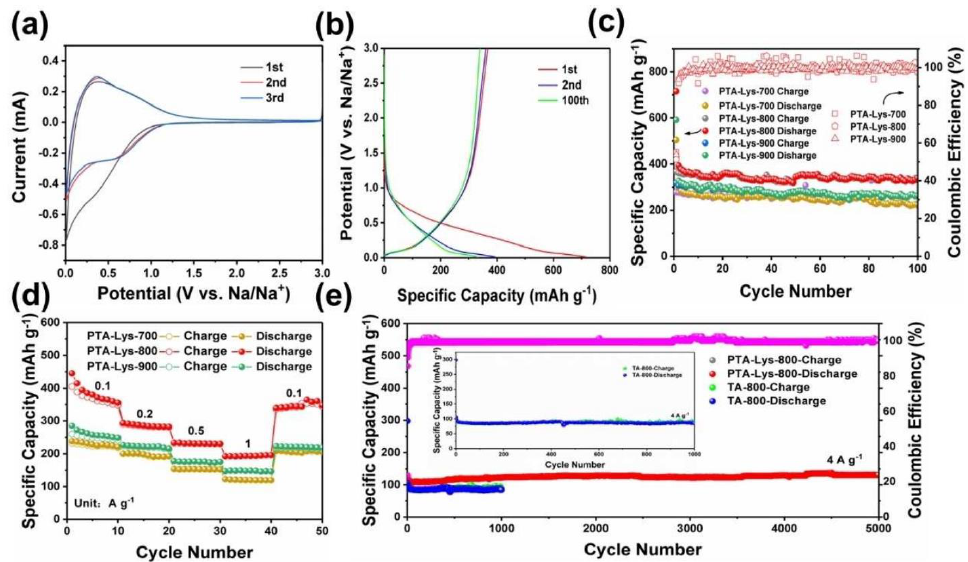
Figure 8. ( a ), CV curve of PTA-Lys-800. ( b ) The GCD curve of PTA-Lys-800 at 100 mA g − 1 . ( c ) Electro- chemical stability of PTA-Lys-800 at 100 mAh g − 1 . ( d ) Rate performance of PTA-NHCS-T. ( e ) Cycling performance of PTA-Lys-800 and TA-800 at 4 A g −1 [107] (copyright Wiley 2022).